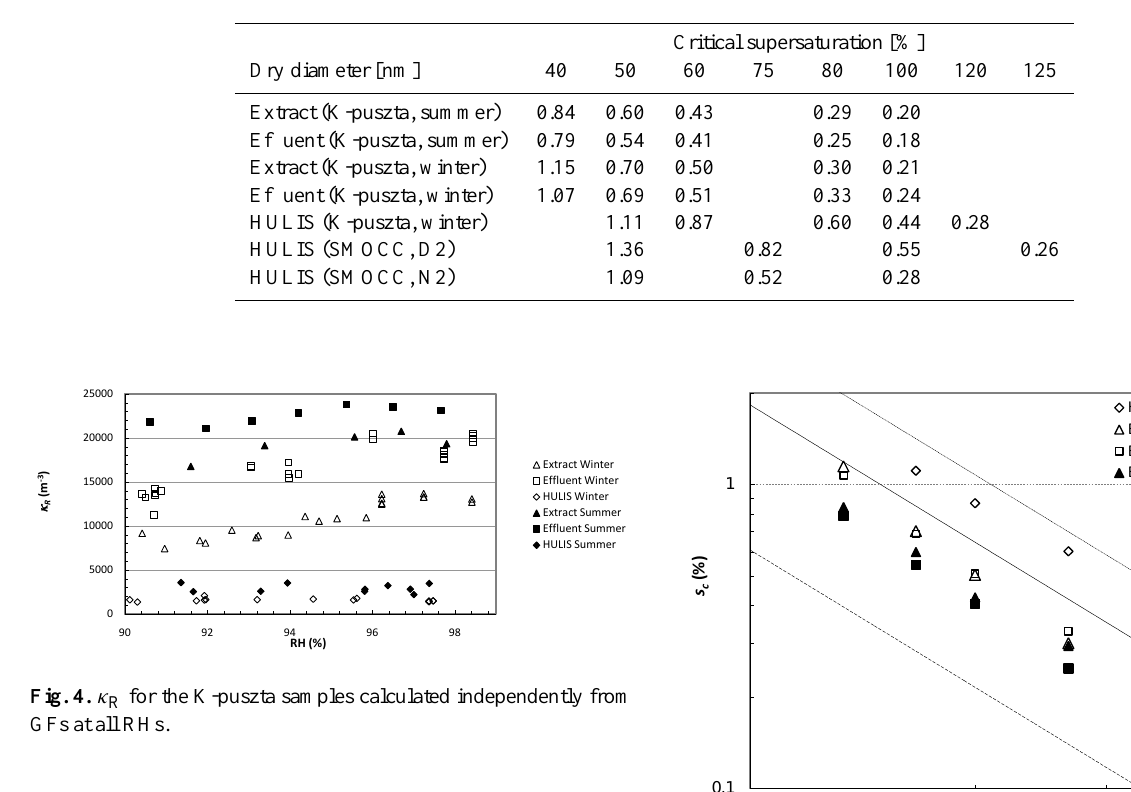
Table 4. Critical supersaturation measured with the CCNCs for different dry diameters for samples from K-puszta and SMOCC.